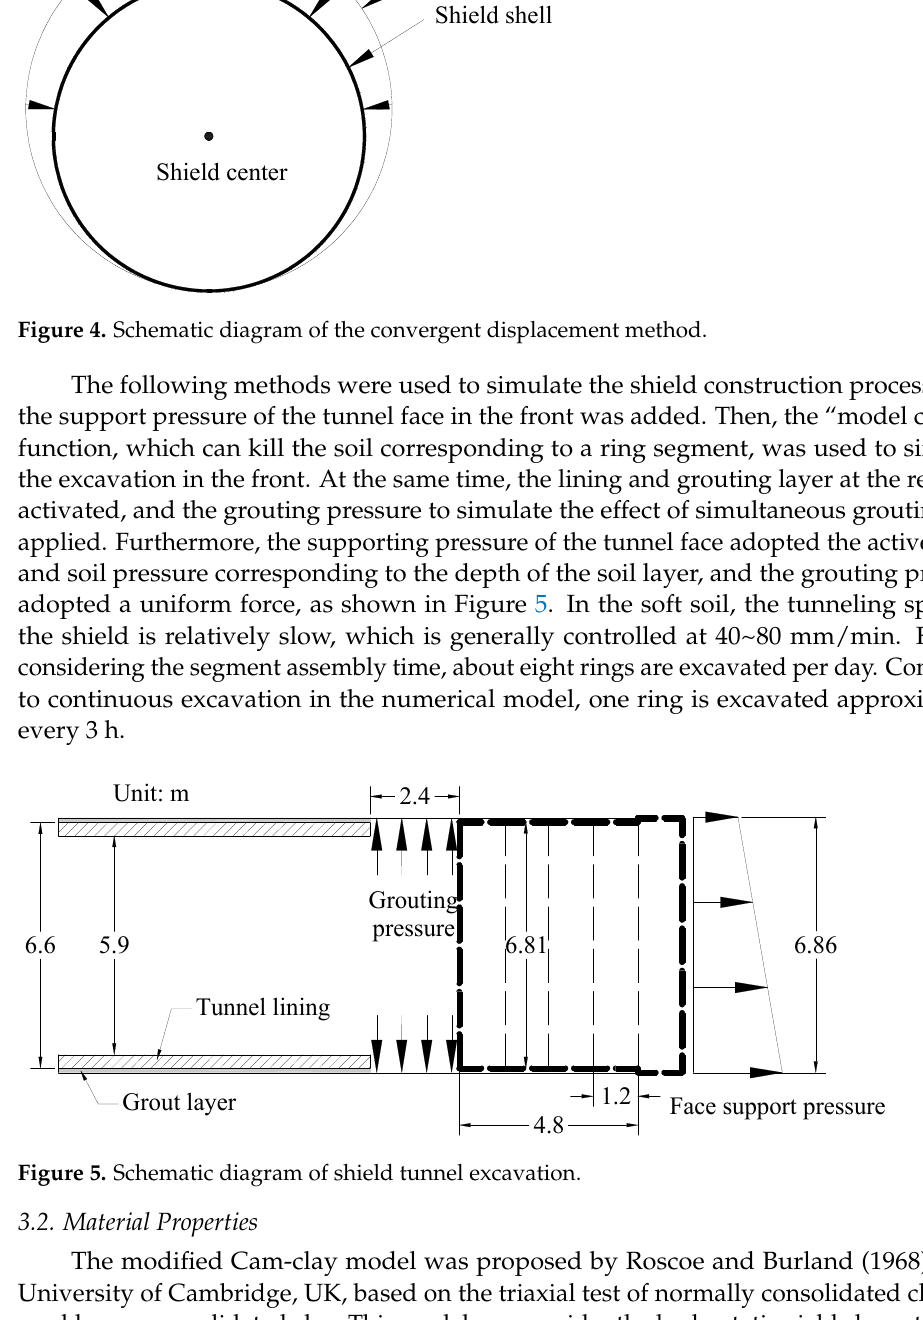
Figure 4. Schematic diagram of the convergent displacement method.